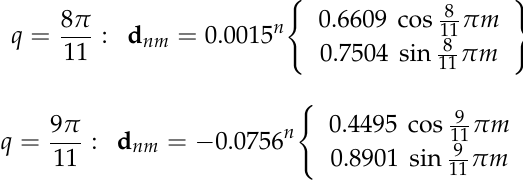
Figure 6. Deformation configuration (scaled) of the 2DoF x-braced lattice ( 𝑘 = 0.93 , 𝑞 = 10 , 𝑛 = 0 → 4 ) given by the analytical solutions (Equations (32) and (33)) in ( a ) and ( b ), respectively.